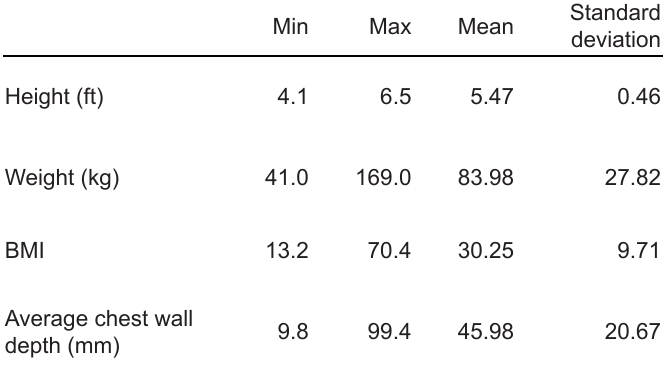
Table. Describes study population by height, weight, body mass index (BMI), and average chest wall depth by minimum (Min), maximum (Max), mean with standard